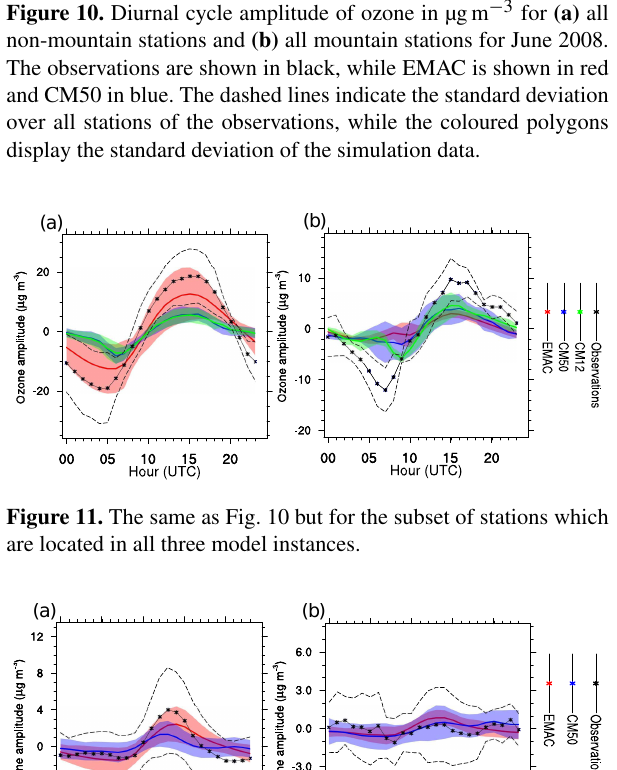
to EMAC ( ± 12 µg m − 3 ). The absolute values of the ob- served noon peak (not shown) are well simulated by both COSMO/MESSy instances ( ≈ 95 µg m − 3 ) and overesti- mated by EMAC ( ≈ 102 µg m − 3 ). Again, the conclusion that the loss overnight is underestimated in CM50. For the moun- tain stations, EMAC and the two COSMO/MESSy instances do not reproduce the small amplitude of the observations ( ≈ ± 10 µg m − 3 ). From the results of the models, CM12 shows the largest amplitude ( ≈ ± 2 µg m − 3 ), which is still much lower compared to the observed amplitude. The mean val- ues have a negative bias for both COSMO/MESSy instances ( ≈ − 5 µg m − 3 ) and a positive bias for EMAC ( ≈ 5 µg m − 3 ).